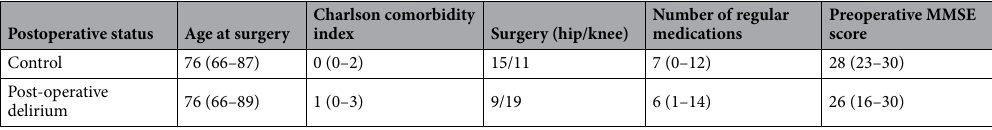
Table 1. Patient characteristics in two cohorts showing matching in terms of age, comorbidities, as well as preoperative MMSE